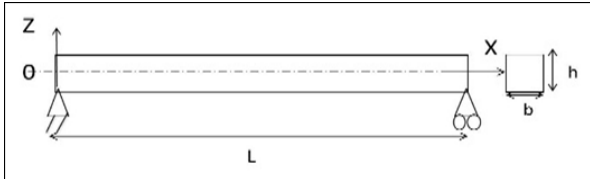
Figure 1: A functionally graded simply supported